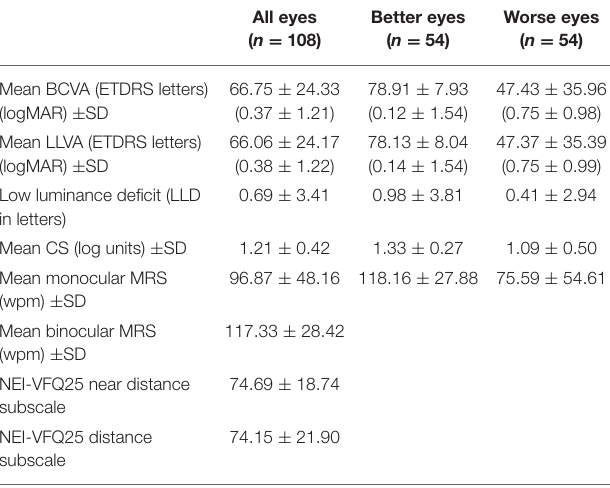
TABLE 2 | Morphologic characteristics.